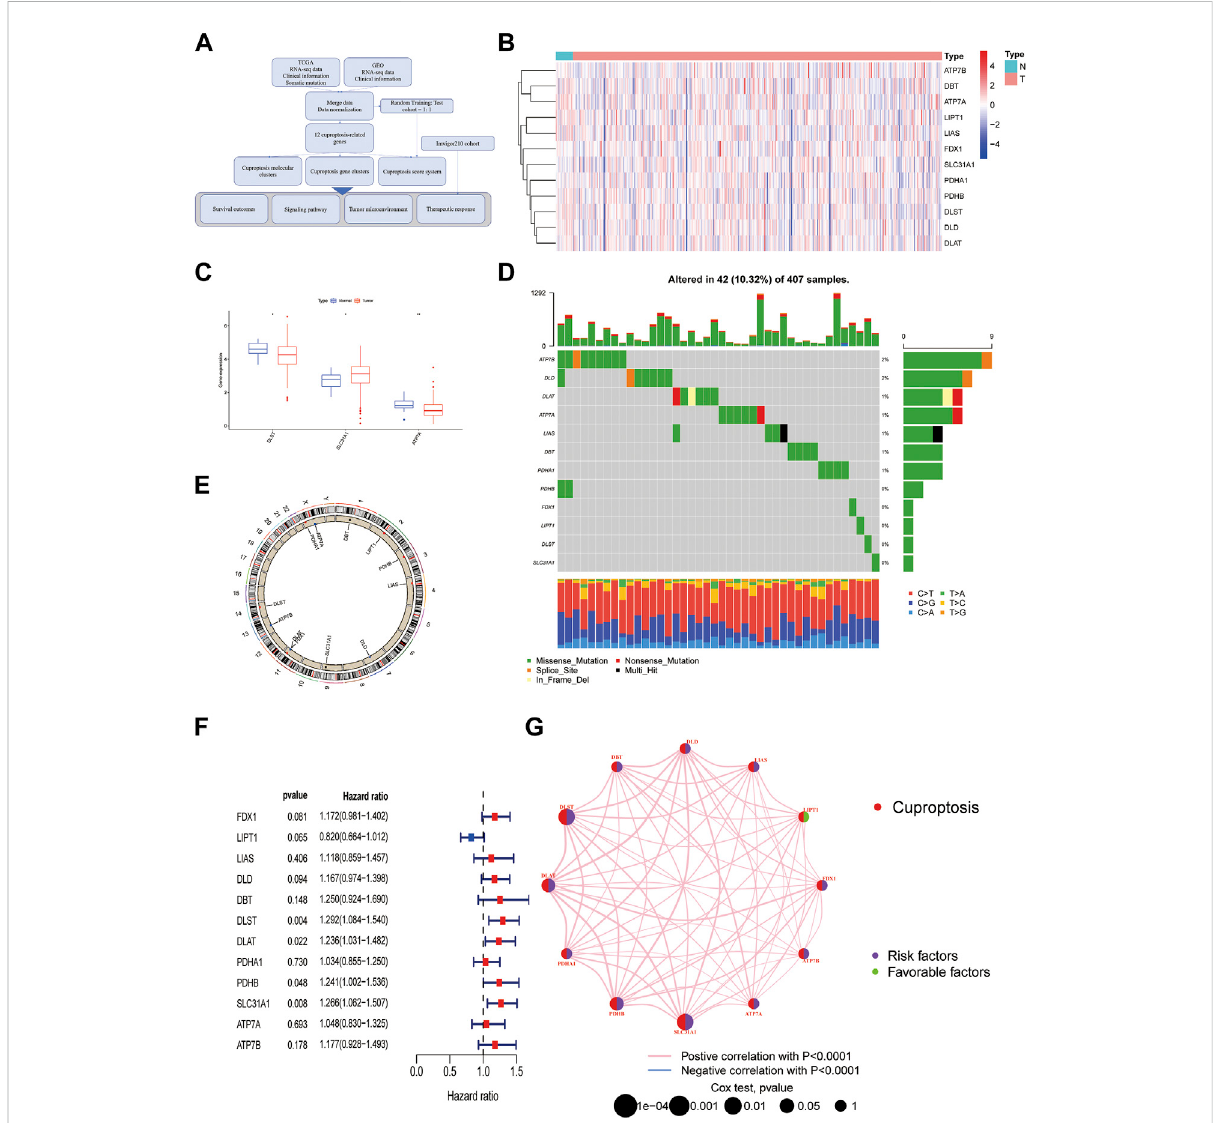
FIGURE 1 AnOverviewofCuproptosisgenesintheTCGAdatabase. (A) Thediagramofthestudy. (B) Heatmapof12CuGsexpressionsamongnormaland tumor samples in the TCGA cohort. (C) Differential CuGs among normal and tumor samples in the TCGA cohort. (D) The landscape of mutation pro fi les of the CuGs in 407 patients from the TCGA cohort. (E) The CNV frequency and location of the CuGs on chromosomes. (F) Forest plots showing the results of the univariate Cox regression analysis of CuGs that were correlated with OS. (G) Expression correlation network of the CuGs. Positive correlations were shown in red lines. Negative correlations were shown in blue lines. The risk factors were shown in purple circles, while the favorable factors were shown in green circles. * p < 0.05, ** p < 0.01. Abbreviations: TCGA, The cancer genome atlas; CuGs, cuproptosis genes; CNV, copy number variation; OS, overall